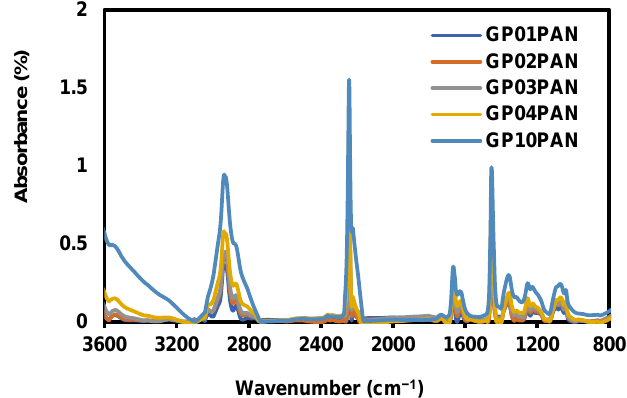
Figure 6. Fourier-transform infrared spectroscopy (FT–IR) spectra of graphene oxide modified by polydiallyldimethylammonium chloride/polyacrylonitrile (GP/PAN) hybrid nanofiber membranes.